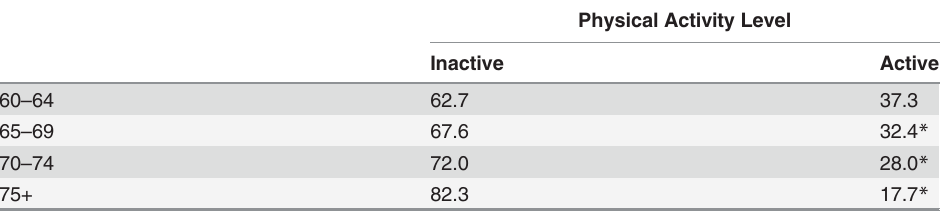
Table 2. The proportion of adults classi fi ed as physically inactive / active according to age.